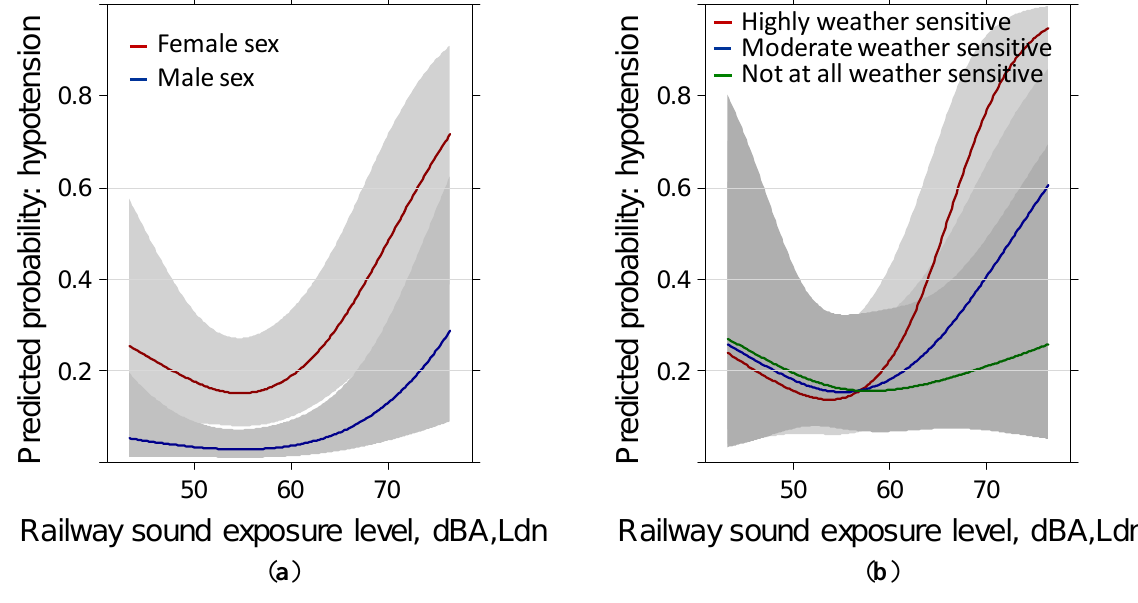
Figure 3. Predicted probability of reported hypotension past year with rail sound level exposure by: ( a ) sex and ( b ) weather sensitivity. Models are adjusted for age, education, BMI, anti-hypertensive treatment, family history of hypertension, health status, sleep score, distance to main road, annoyance by local roads, region and the IA-terms age × sex, weather sensitivity × health, weather sensitivity × sound exposure, distance × sound exposure, annoyance × sound